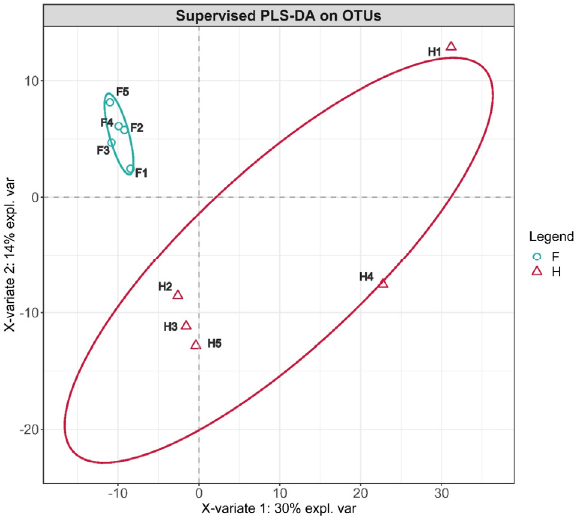
Figure 2. Supervised PLS − DA on OTUs. F means factory production; H means household hand- made.